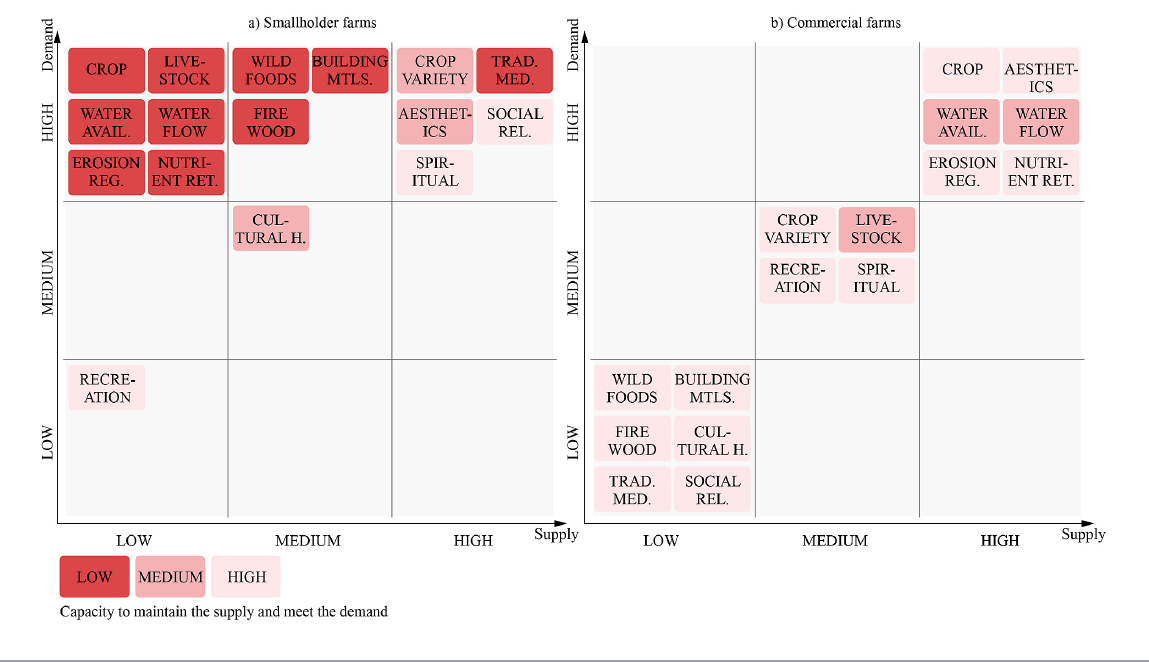
Fig. 3 . Comparison between smallholder (a) and commercial (b) agricultural landscapes (cropland and grazing land combined) in terms of the supply of 16 ecosystem services (x-axis: low, medium, and high), the demand thereof (y-axis: low, medium, and high), and the capacity of the farmer groups to maintain the supply and meet the demand (color of box: low = dark red; medium = pink; and high = light